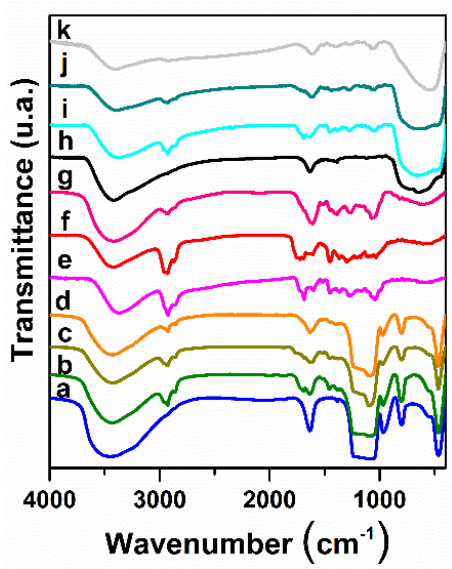
Figure 4. FTIR spectra for ( a ) MCM-41E; ( b ) So(MW)-1@MCM-41E; ( c ) So(Conv)-2@MCM-41E; ( d ) Ts(Conv)-2@MCM-41E; ( e ) So(MW)-1; ( f ) So(Conv)-2; ( g ) Ts(Conv)-2; ( h ) TiO 2 ; ( i ) So(MW)-2@TiO 2 ; ( j ) So(Conv)-2@TiO 2 ; and ( k )Ts(Conv)-2@TiO 2 .